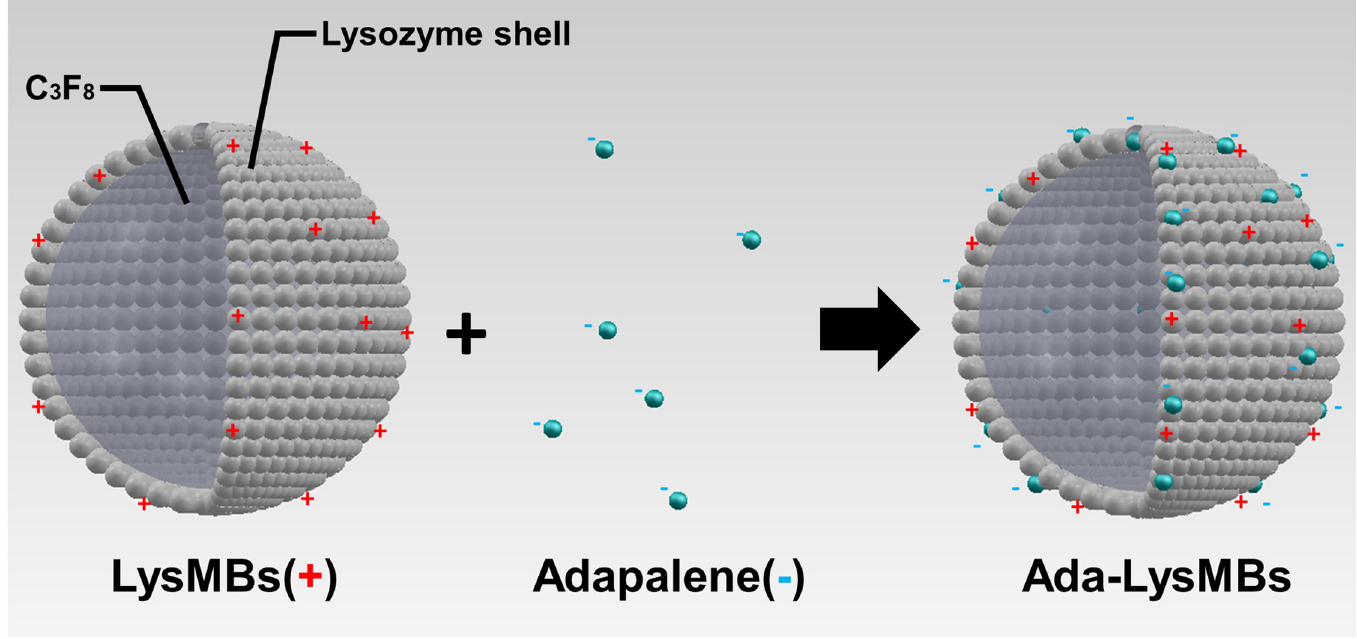
Fig 1. Schematic (not to scale) of the self-assembly of Ada-LysMBs.